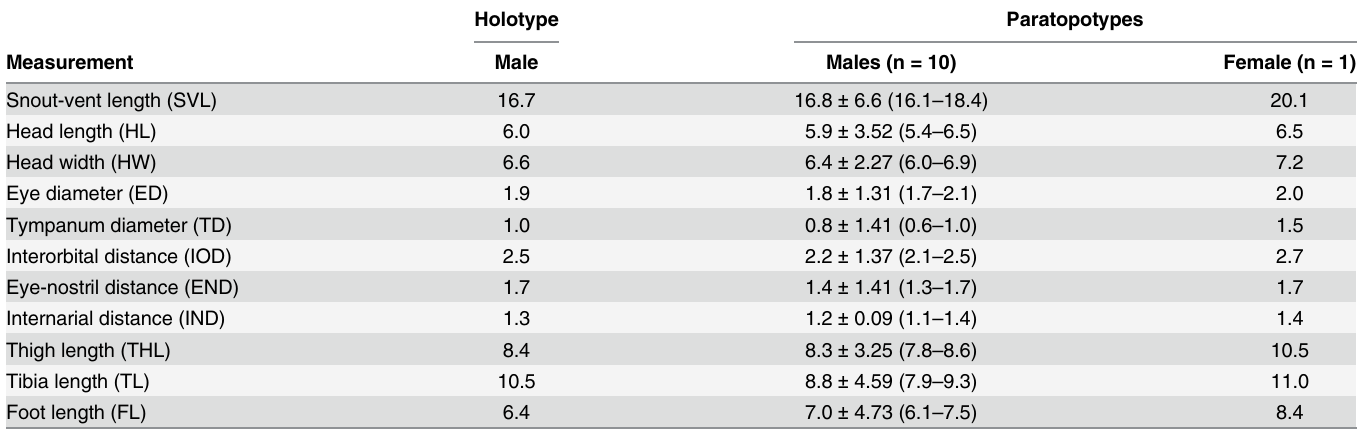
Table 1. Measurements of the type series of Dendropsophus bromeliaceus sp. nov.. Values in millimeters presented as mean ± standard deviation